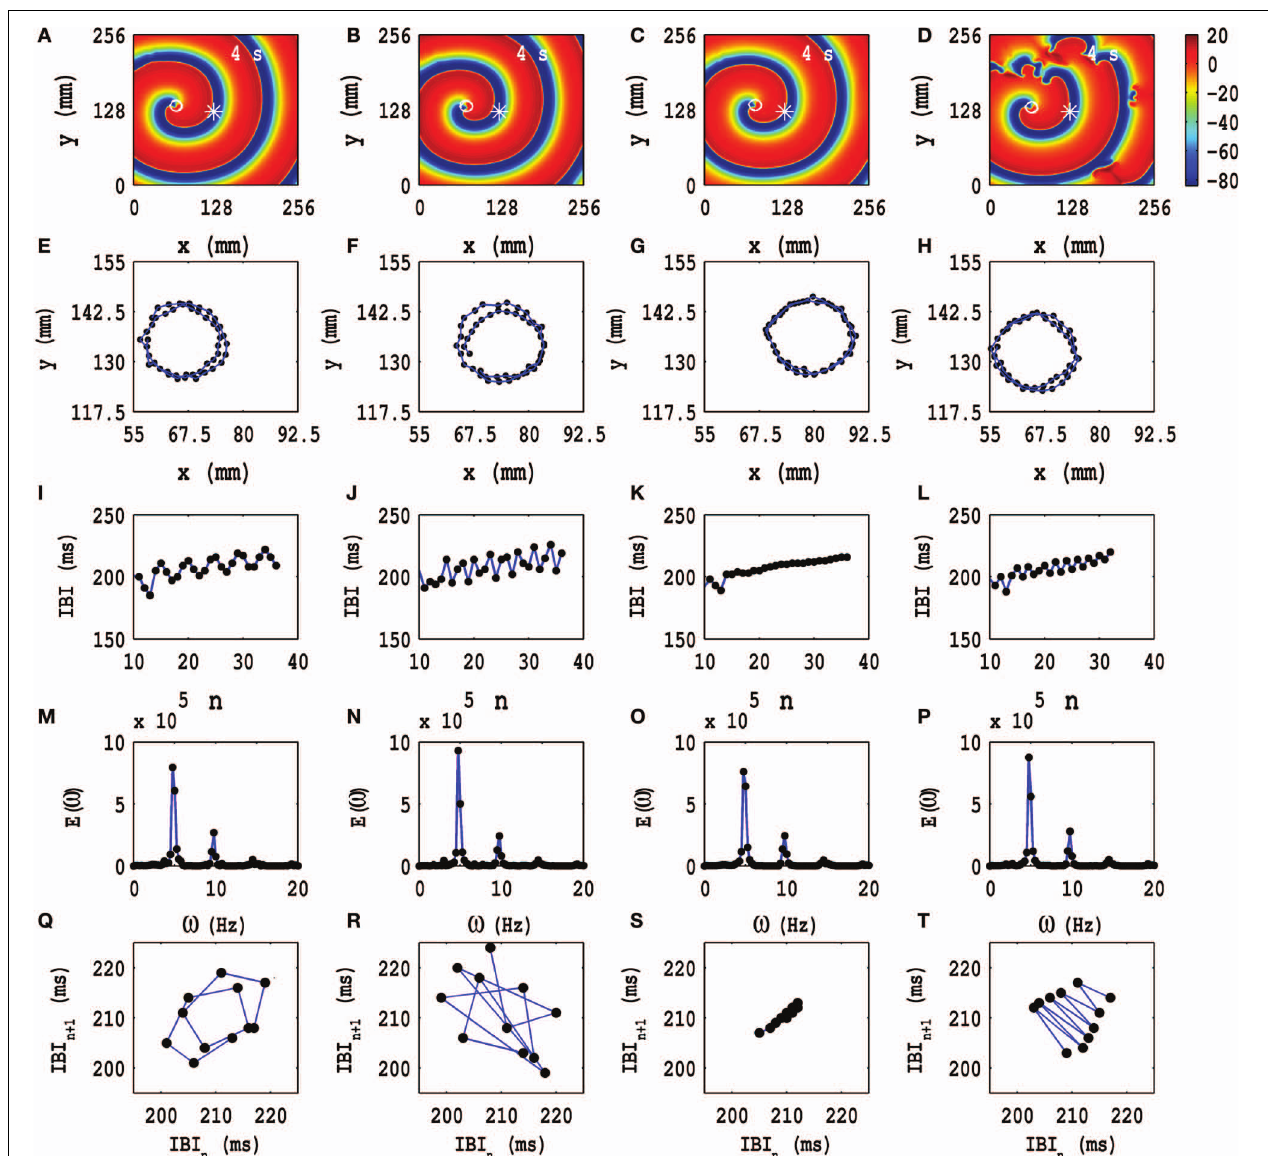
FIGURE 4 | Time evolution of the RS state in the TP06 model in the presence of PD with a fixed amplitude. Pseudocolor plots of V m at time t = 4s for (A) A x = A y = 0 . 1 , f x = f y = 1 . 0Hz, (B) A x = A y = 0 . 1 , f x = f y = 3 . 0Hz, (C) A x = A y = 0 . 1 , f x = f y = 5 . 0Hz, and (D) A x = A y = 0 . 1 , f x = f y = 7 . 0Hz, respectively; the animations (a1), (b1), (c1), and (d1) in Video S3 show the spatiotemporal evolution of V m for these cases in the time interval 0s ≤ t ≤ 4s. (E–H) Spiral-tip trajectories, which follow from these spatiotemporal evolutions, for 3 . 6s ≤ t ≤ 4s [in (H) we give the tip trajectory for the main, central spiral (D) ]. We obtain the local time series of V m ( x , y , t ), from the representative point ( x = 125 mm, y = 125mm) [the asterisks in (A–D) ], and therefrom the plots of the IBI (I–L) and the power spectra (M–P) . The discrete peaks in E ( ω ) appear at the